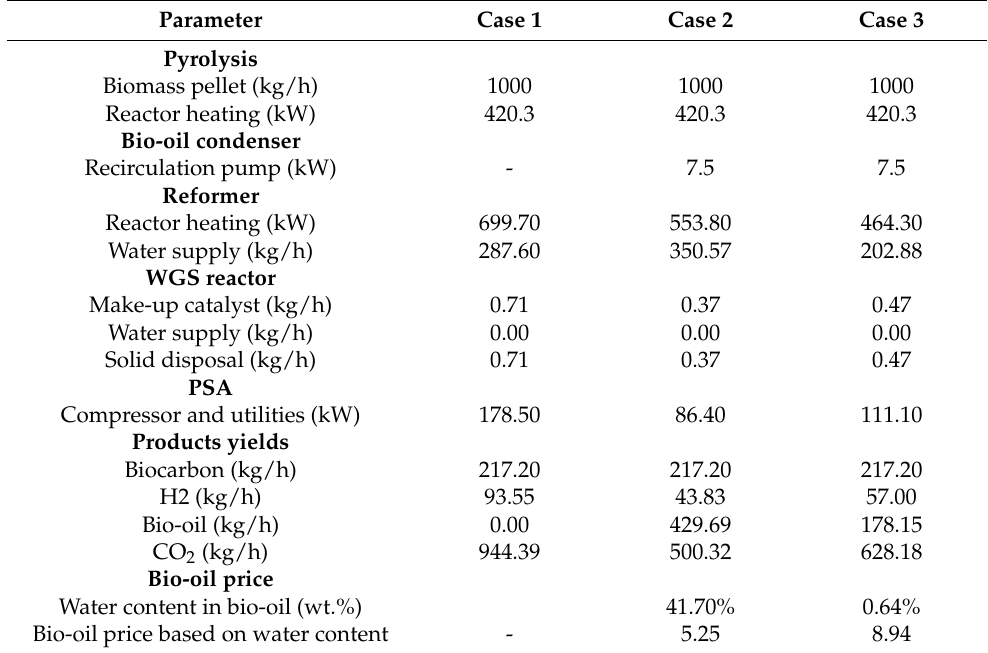
Table 10. Summary of the main process parameters for OPEX